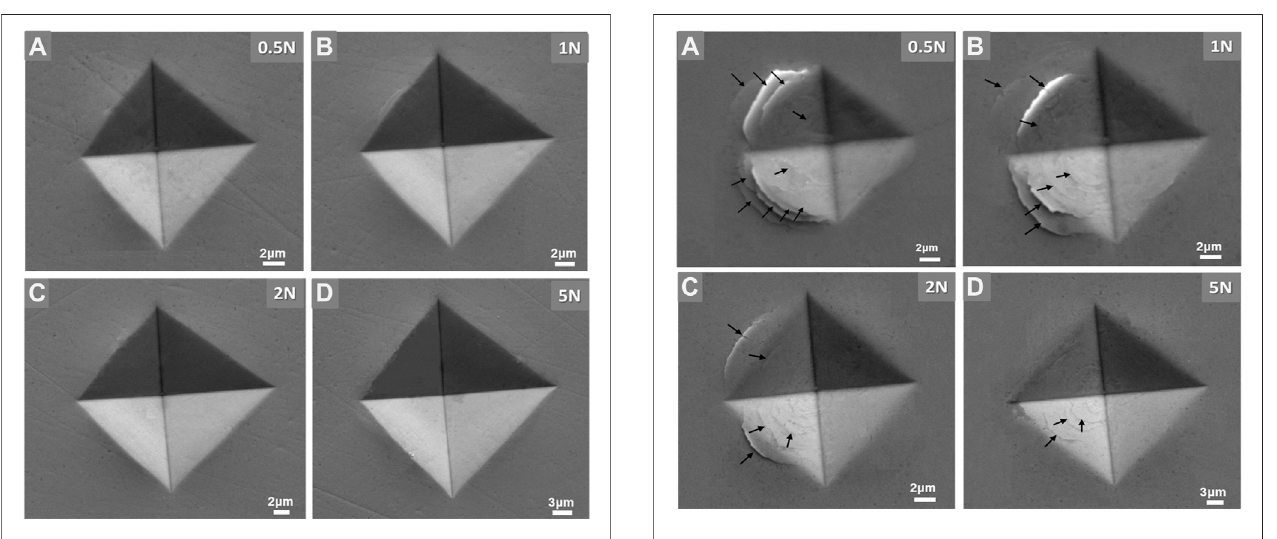
FIGURE 4 | Representative SEM images of Vickers indentation imprints ofAPNGsmaximumindentationload, P max ,of (A) 0.5 N, (B) 1 N, (C) 2 N,and (D) 5 N.